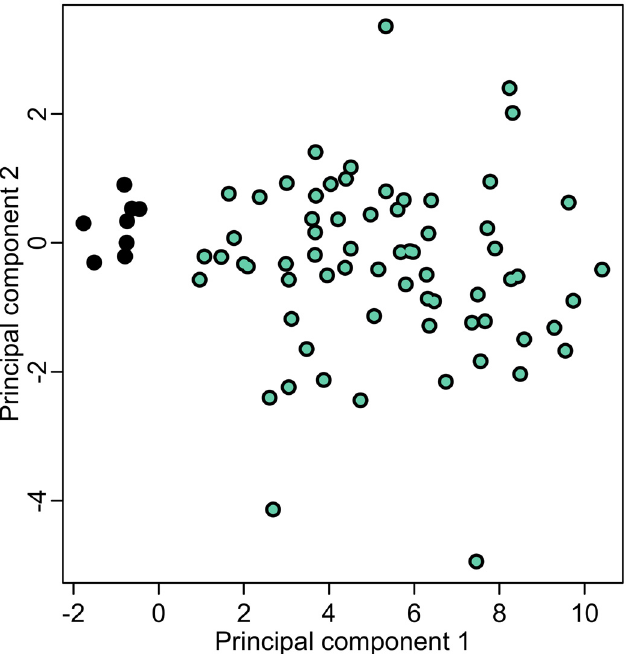
Fig 4. Principal Component Analysis. PCA analysis of regression residuals for 75 differential drift CpGs identified from data set D2. The green points designate the 67 BE clock CpG set. See text for details.